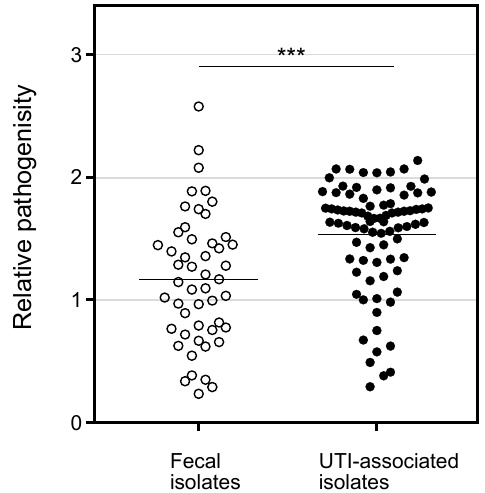
Figure 2. Pathogenicity of E. coli clinical isolates in liquid killing assay with C. elegans. The pathogenicity (relative OD 592nm value in the liquid assay) of the fecal and UTI-associated isolates were plotted. The value for MG1655 as a model strain for fecal isolate was 1.17, and that for UTI89 as a model strain for UTI associated isolate was 1.75. The horizontal bars represented the mean values. The results were analyzed statically by the Mann-Whitney U test. (**, p < 0.01). The pathogenicity of UTI-associated isolates was significantly higher than that of fecal isolates. Table 2. The association between pathogenicity and virulence factor.